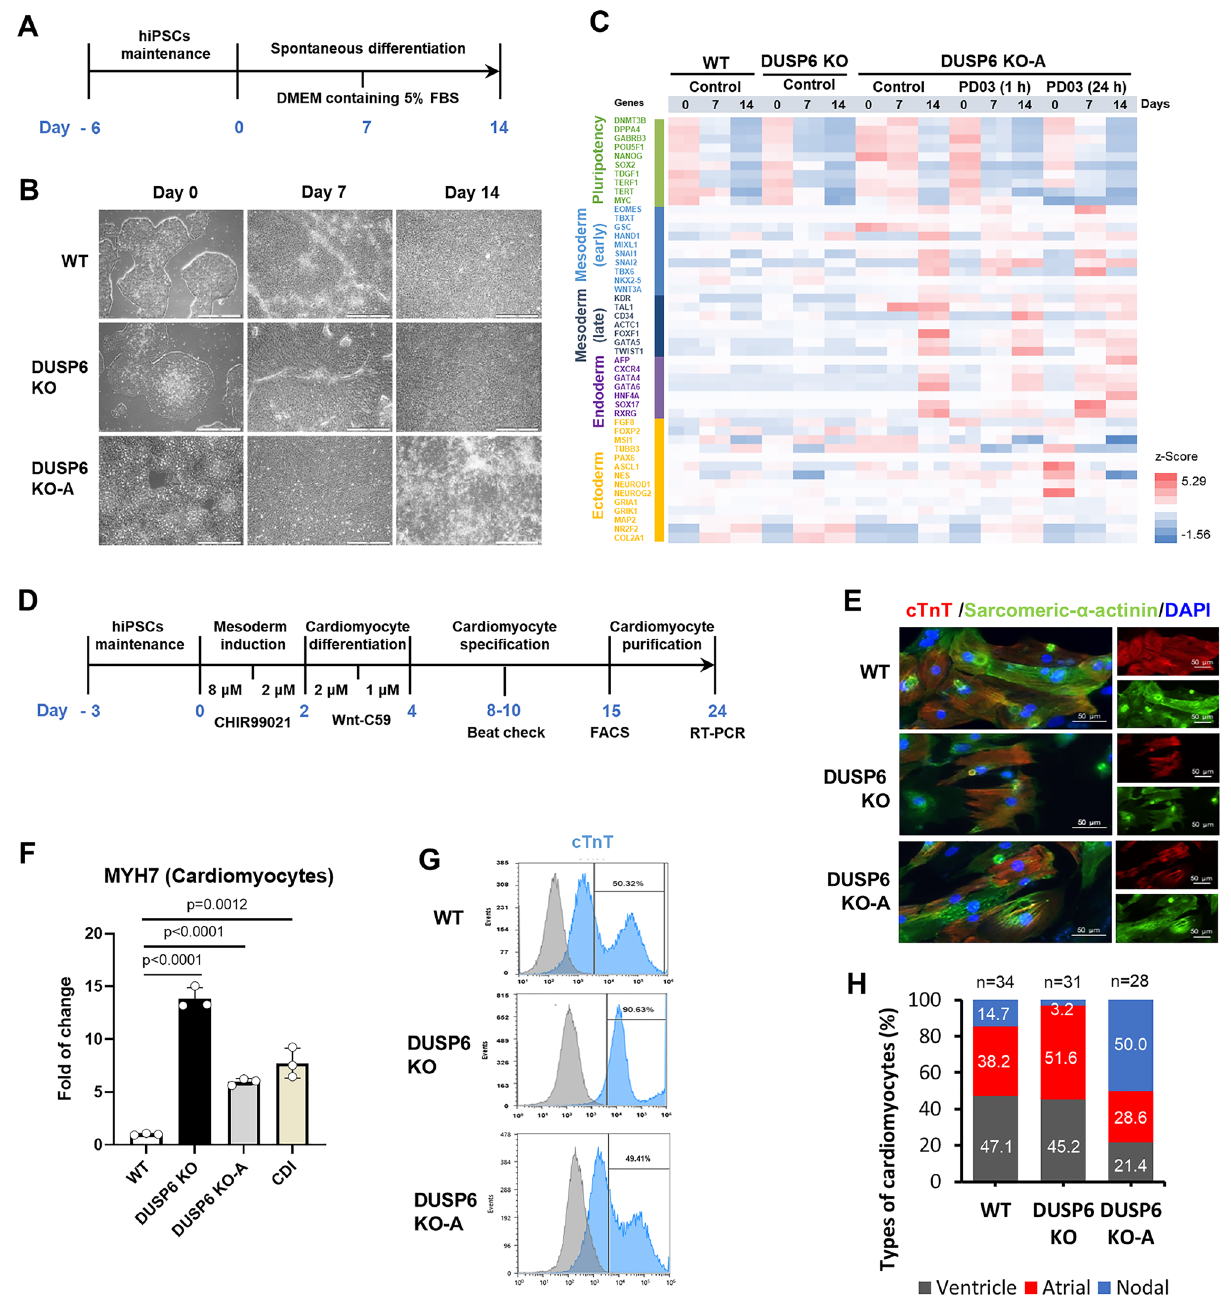
Figure 5. Effect of DUSP6 depletion on hPSC differentiation propensity. ( A ) Spontaneous differentiation scheme. Briefly, cells were maintained in the TeSR-E8 medium and spontaneous differentiation was induced by adding DMEM containing 5% FBS. ( B ) Images of colonies and differentiated cells before harvesting. ( C ) Estimation of differentiation propensities of WT and DUSP6 KO cells. Heatmap was created with z-Score calculated from RPKM values of RNA-seq data. To suppress the ERK signaling, WT cells were treated with the MEK inhibitor (PD0325901, 1 mM) for 1 h before initiating differentiation. ( D ) Cardiomyocyte differentiation scheme. Briefly, cells were maintained in the StemMACS iPS-BREW XF media. Mesoderm differentiation was induced with CHIR99021 and cardiomyocyte differentiation was induced with Wnt-C59. Cardiomyocyte specification was confirmed by evaluating the cell beating. ( E ) Cardiomyocytes were stained for cardiac troponin T (cTNT), sarcomeric-α-actinin, and DAPI (scale bar, 50 μm). ( F ) Expression of the mature cardiomyocyte marker, MYH7, was measured using real-time PCR (n = 3). mRNAs from cardiomyocytes generated from CDI and primary heart tissue were used a positive control. P-values are indicated. ( G ) Cardiomyocyte differentiation was assessed by evaluating cTnT-positive cells using FACS. ( H ) Types of cardiomyocytes derived from WT, KO, and KO-A